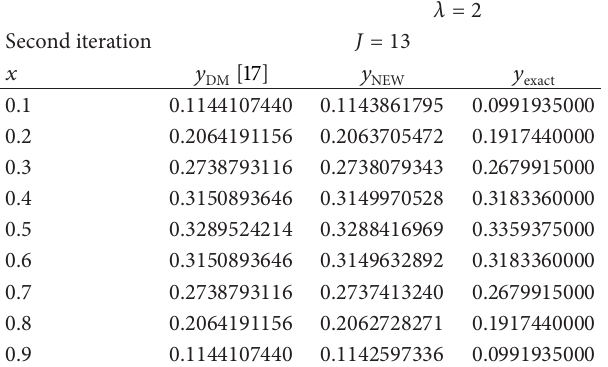
, solution by decompo- Table 3: Comparison of exact solution 𝑦 exact , and solution by the wavelet-Galerkin method sition method 𝑦 DM at second iteration and 𝐷12 with quasilinearization technique 𝑦 NEW is used as Galerkin bases.